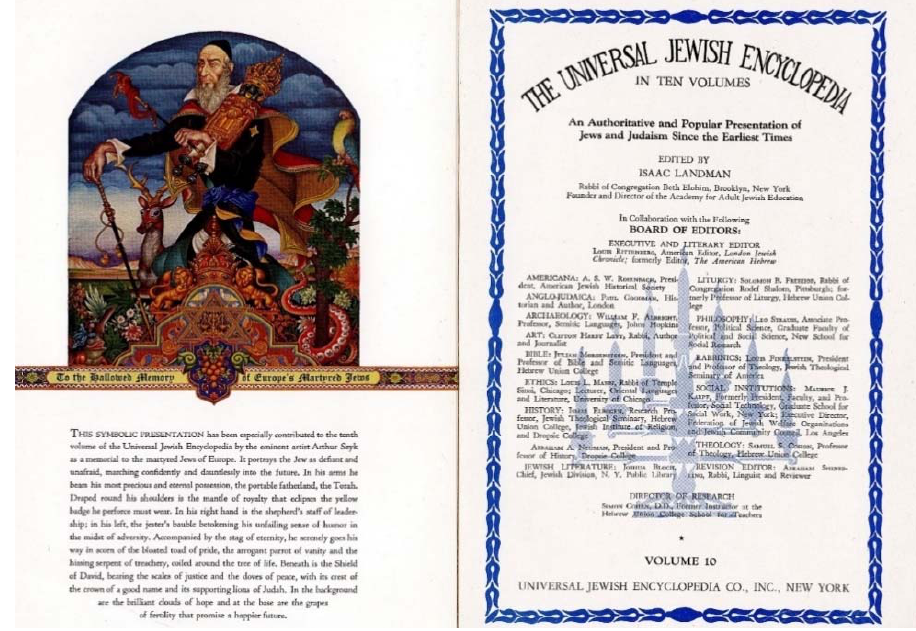
Figure 12. Frontispiece to Volume 10 of the 1943 Universal Jewish Encyclopedia , 1948.